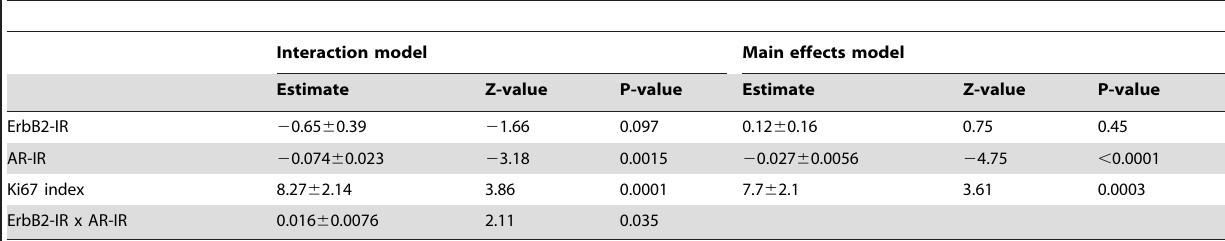
Table 3. Ordinal regression analyses with tumour ErbB2-IR, AR-IR and Ki67-index as the independent variables and the tumour stage as the dependent variable.